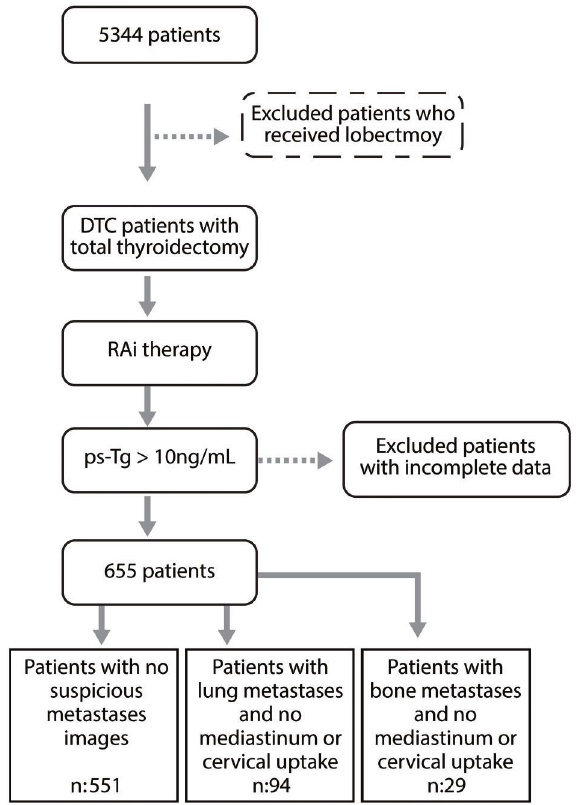
Figure 1. Flow chart of inclusion-exclusion of patients in the present study. DTC: differentiated thyroid cancer; RAI: radioactive iodine; ps-Tg: postoperative stimulated